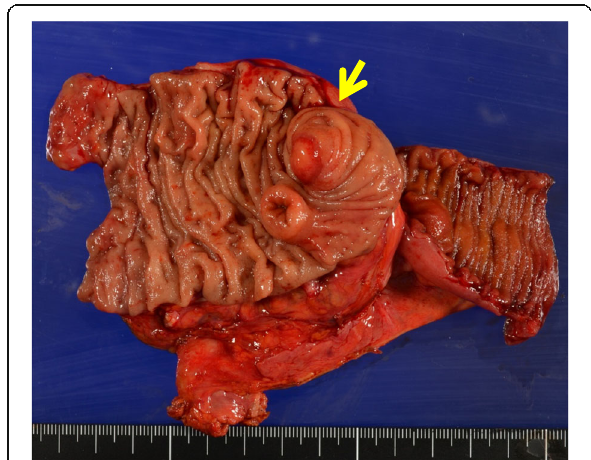
Fig. 4 The excised specimen contained a submucosal tumor-like protruding lesion (arrow) at a location consistent with the appendiceal orifice